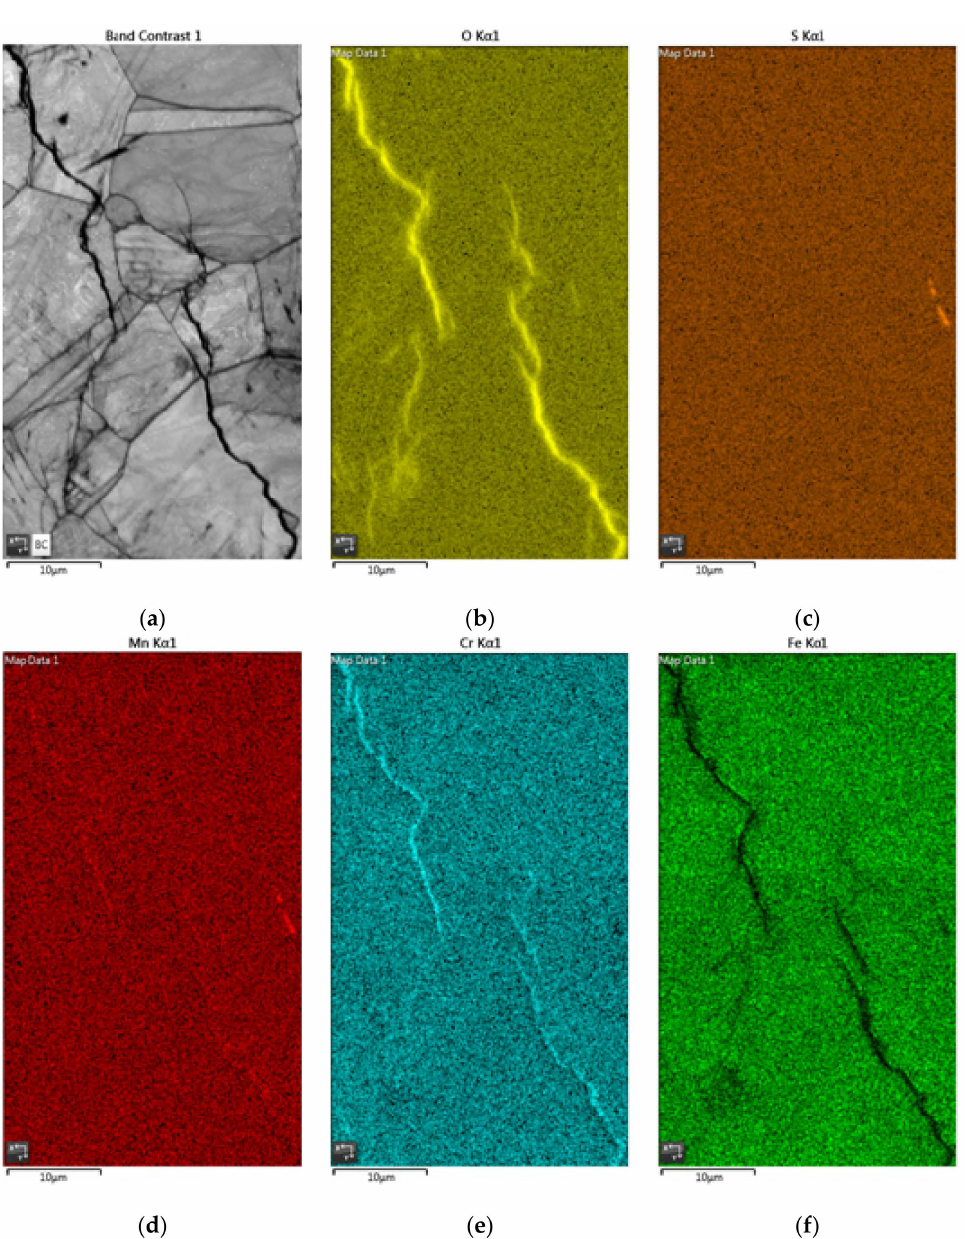
Figure 8. EDS mapping for the crack region after 5000 h tests with 1 g / m 2 chloride concentration and relative humidity of 55%. ( a ) Band contrast image, ( b ) O mapping, ( c ) S mapping, ( d ) Mn mapping, ( e ) Cr mapping, and ( f ) Fe